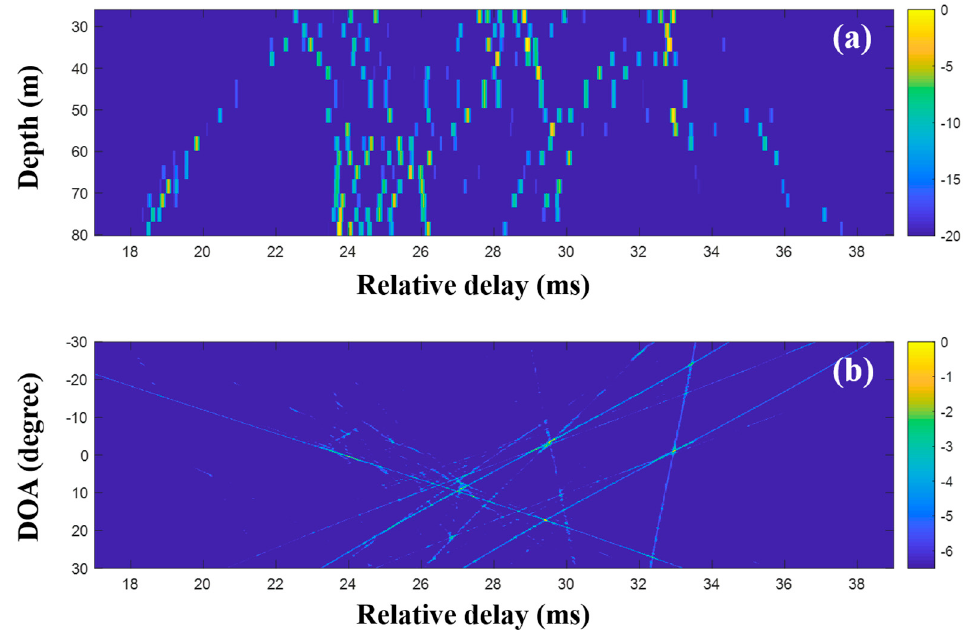
Figure 17. Direction-of-arrival (DOA) estimation using extended compressive sensing (CS) with multiple snapshots captured by the vertical line array (VLA) in SAVEX15 (11–31 kHz): ( a ) arrival structures via sequential CS usage applied to the signals at the VLA and ( b ) DOAs using the delay-and-sum beamforming with the arrival structures.